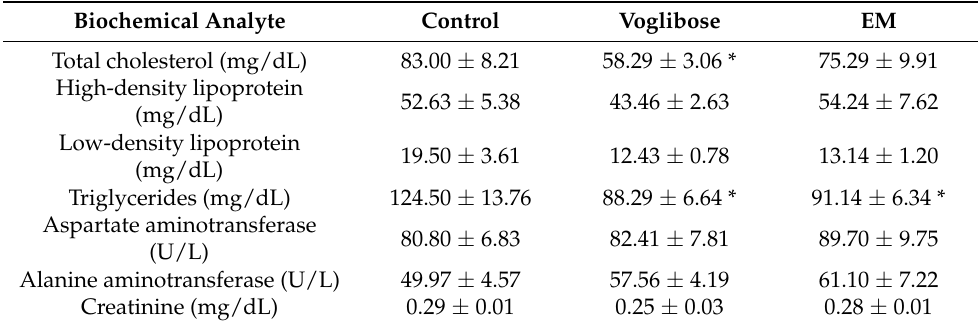
Table 2. Biochemical examination after EM administration. Biochemical Analyte